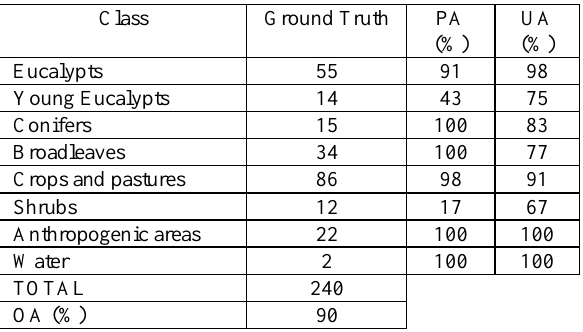
Table 2. Results of the cross-verification of the general classification. Ground Truth: Number of Ground Truth points; PA: Producer’s Accuracy; UA: User’s Accuracy, OA: Overall Accuracy.